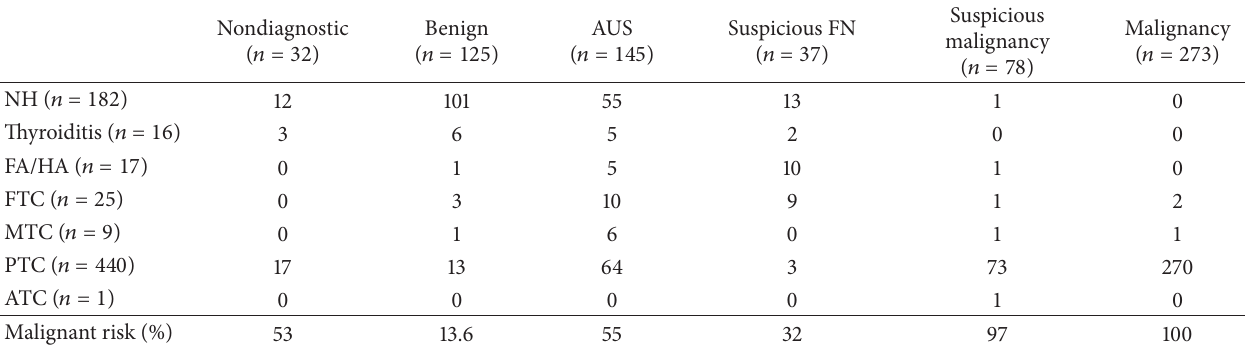
Table 1: Final pathological results of the nodules divided according to the Bethesda fine-needle aspiration cytology (FNAC)